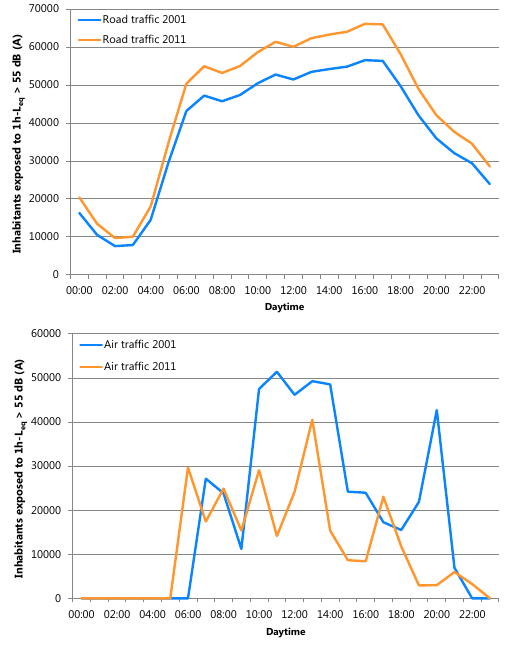
Fig. 9. Number of affected inhabitants by road and air traffic noise (1h-L eq ) >55 dB (A) for an area of 35 km 2 south of Zurich airport.